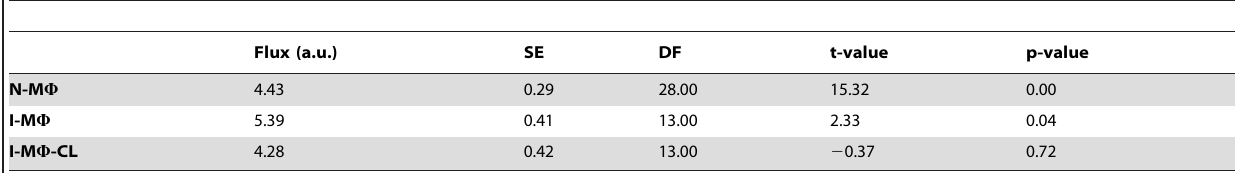
Table 2. Analysis of the PLC d 1-GFP movement at the boundary of cells as measured by computational analysis using equation (1.1)for N-M W , I-M W and I-M W -CL.